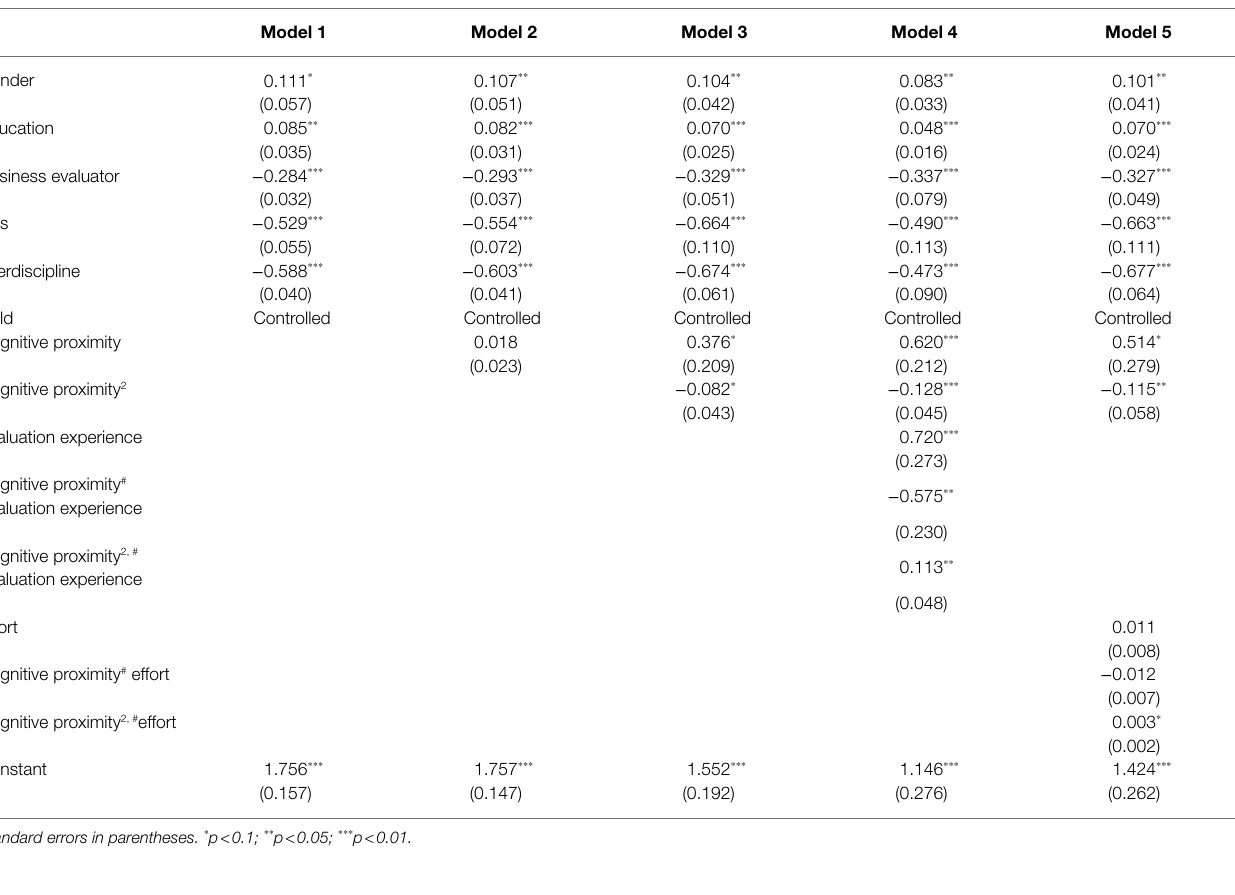
TABLE 2 | Negative binomial regression models.